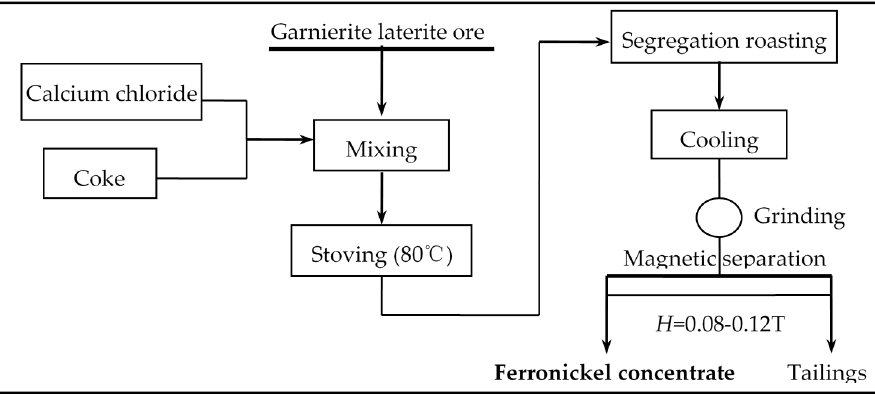
Figure 2. Scheme of the nickel extraction process from nickel silicate ore.